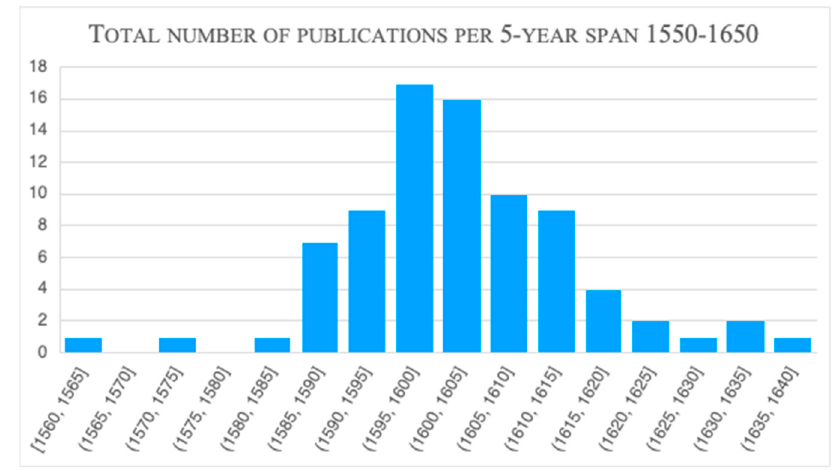
Figure 1. Total Number of Publications of Lagrime Poems per 5-Year Span 1550–1650.